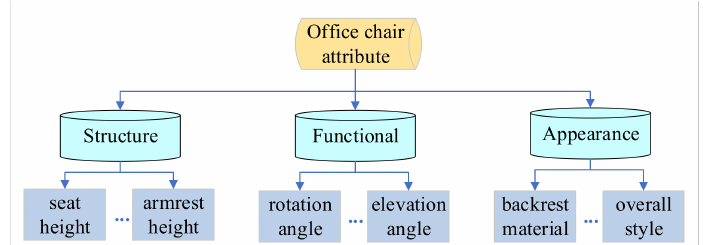
Figure 3. Office chair pattern characteristic